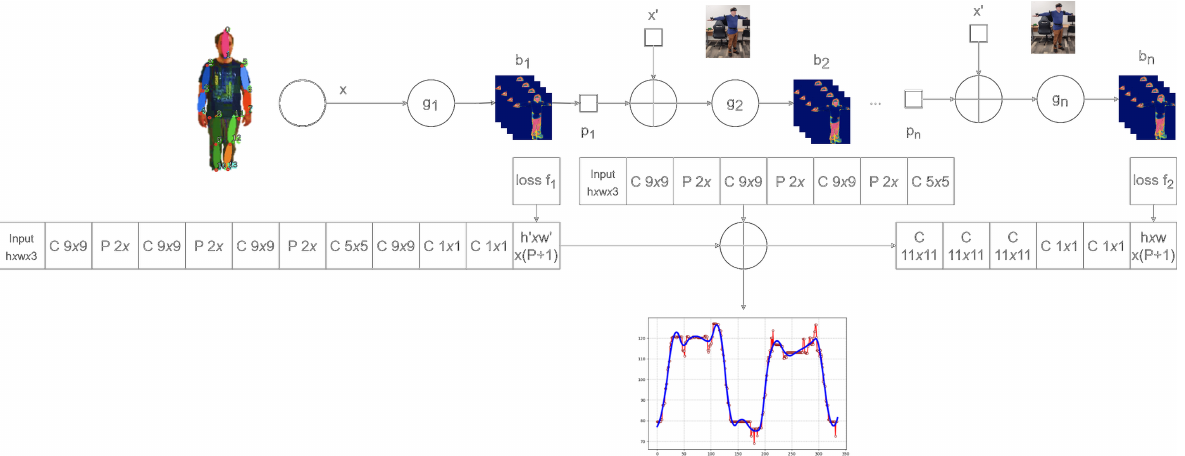
Figure 2. Deep neural network architecture of motion recognition system. Network supplements the IK model with motion curves in its output (in blue) and motion deviations (in